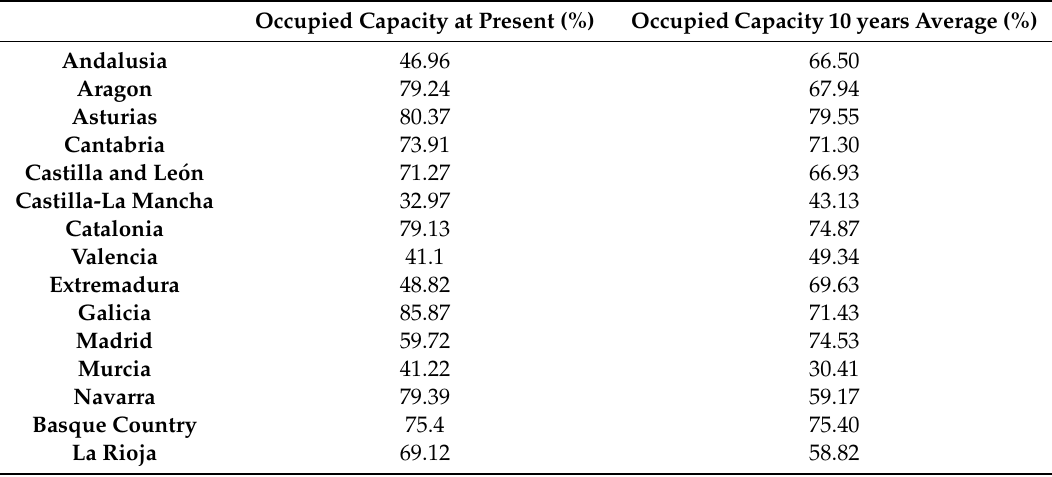
Source: own elaboration from INE data. Table A6. Occupied capacity of reservoirs by region except the insular territories, Ceuta and Melilla. Occupied Capacity at Present